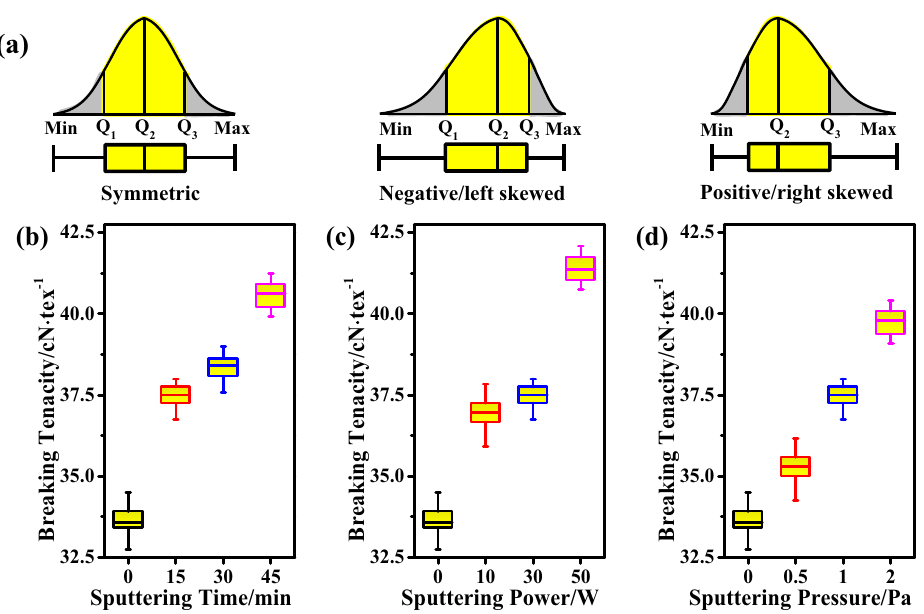
Figure 6: ( a ) Schematic of typical distributions in a boxplot form; boxplots of ( b ) sputtering time, ( c ) sputtering power, and ( d ) sputtering pressure - dependent tensile strength of PP fi